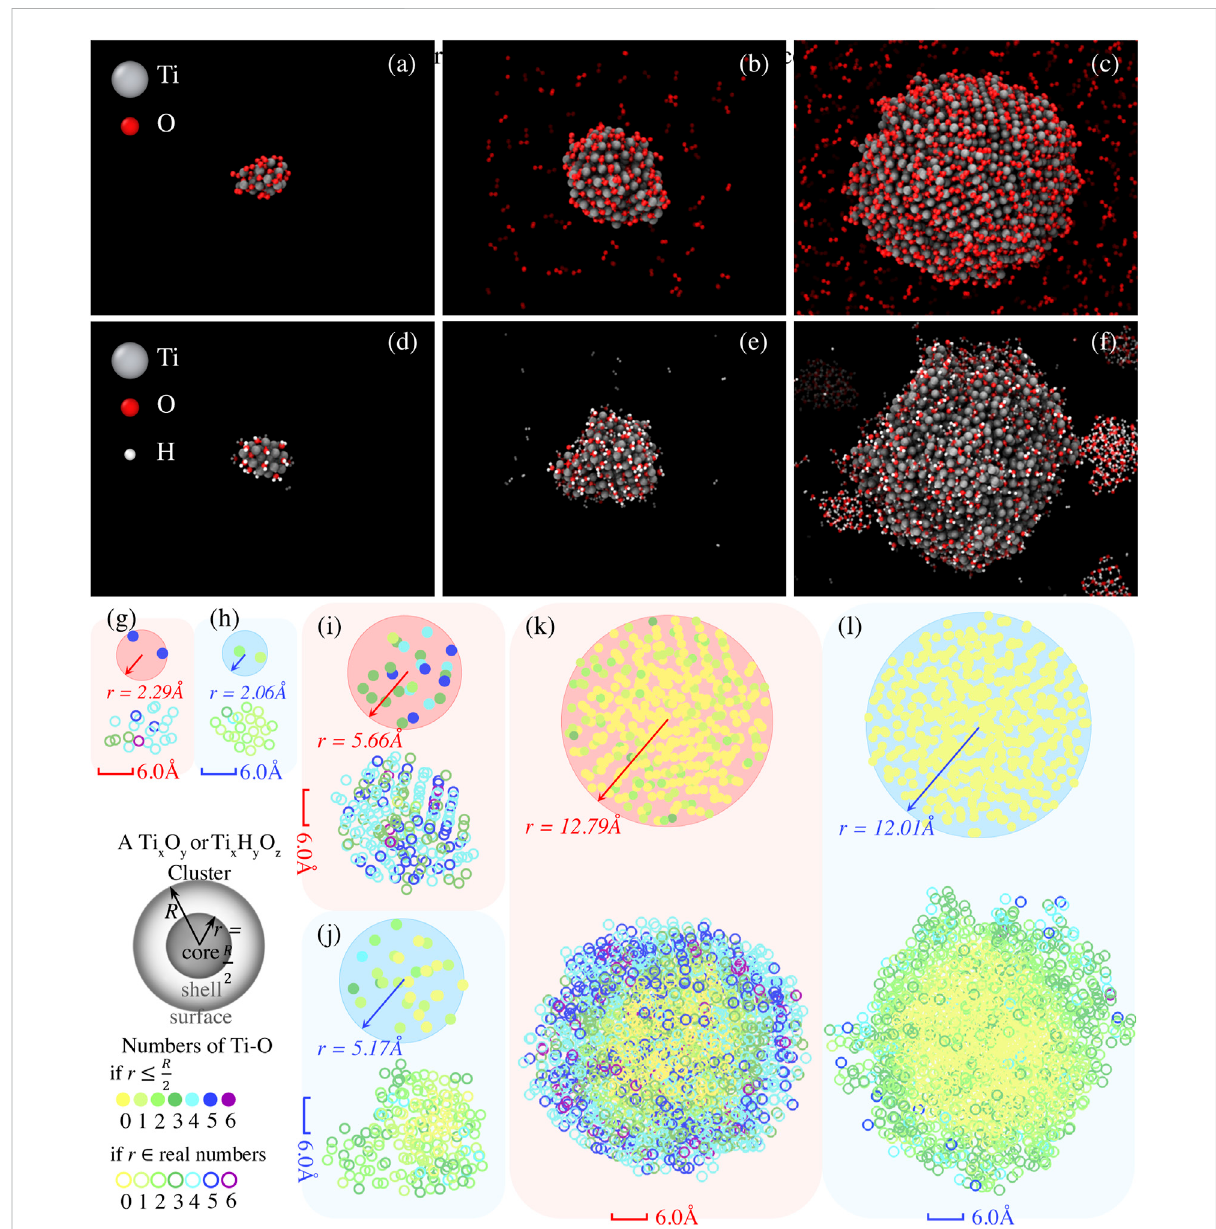
FIGURE 4 Adsorption of O 2 and H 2 O molecules on Ti cluster with varying size. The molecular snapshots showing Ti 20 cluster with (A) 20 O 2 molecules (Ti 20 +20O 2 )and (D) 20H 2 Omolecules(Ti 20 +20H 2 O),Ti 200 clusterwith (B) 200O 2 molecules(Ti 200 +200O 2 )and (E) 200H 2 Omolecules(Ti 200 + 200H 2 O),aswellasTi 2000 clusterwith (C) 2000O 2 molecules(Ti 2000 +2000O 2 )and (F) 2000H 2 Omolecules(Ti 2000 +2000H 2 O),areextractedat t= 500ps during NVT simulationsat 300 K. Accordingly, Ti atoms constitutingTi-O or Ti-OH that are projected onto thex-y plane aregiven to identify the size-dependent oxidation states of core and shell ofTi clusters, as can be seen in (G) for Ti 20 + 20 O 2 , (H) for Ti 20 + 20 H 2 O, (I) for Ti 200 + 200O 2 , (J) Ti 200 + 200 H 2 O, (K) Ti 2000 + 2000O 2 ,and (L) Ti 2000 + 2000H 2 O. The solidcircles represent the numbers ofTiatomsconstitutingTi-O orTi-OH within thecore (i.e., r ≤ R , where Ris theradius oftheTi cluster). The hollow circles represent thenumbersof Tiatoms constituting Ti-O or 2 Ti-OH within the entire cluster. The core is projected to the center of x-y plane and colored red for the cases with O 2 and colored blue for the cases with H 2